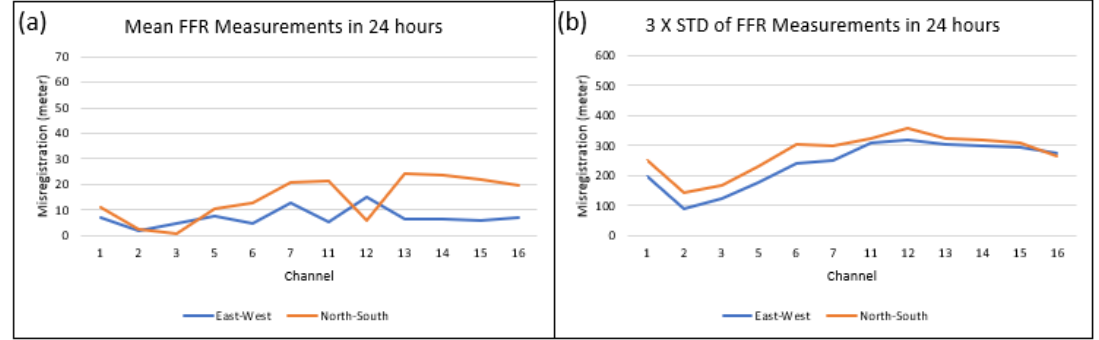
Figure 15. The mean ( a ) and three times standard deviation ( b ) of frame-to-frame error of a 24-hour period (June 1st 18:00 UTC to June 2nd 17:59 UTC 2019) for GOES-16. The misregistration is converted to nadir equivalent distance from the angular space of the fixed grid projection.